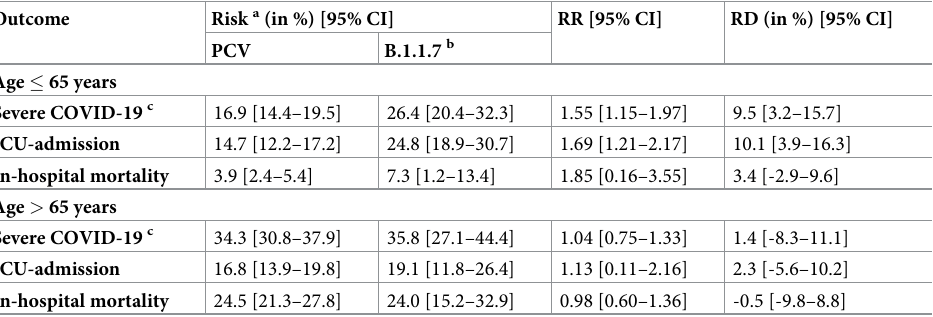
Table 3. Risk per exposure group (in %), Relative Risk (RR) and Risk Difference (RD, in %) estimates and 95% Confidence Interval (CI) for main and secondary outcomes, stratified per age group, within a multi-center matched cohort study to assess the impact of SARS-CoV-2 variants on COVID-19 disease severity among hospi- talized patients in Belgium. Outcome